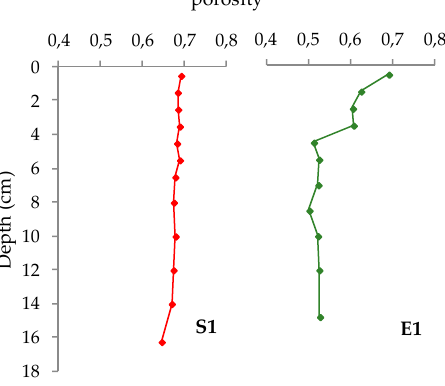
Figure 2. Porosity vs. depth profiles for S1 and E1 cores (cruise ANOC ‐ 16).